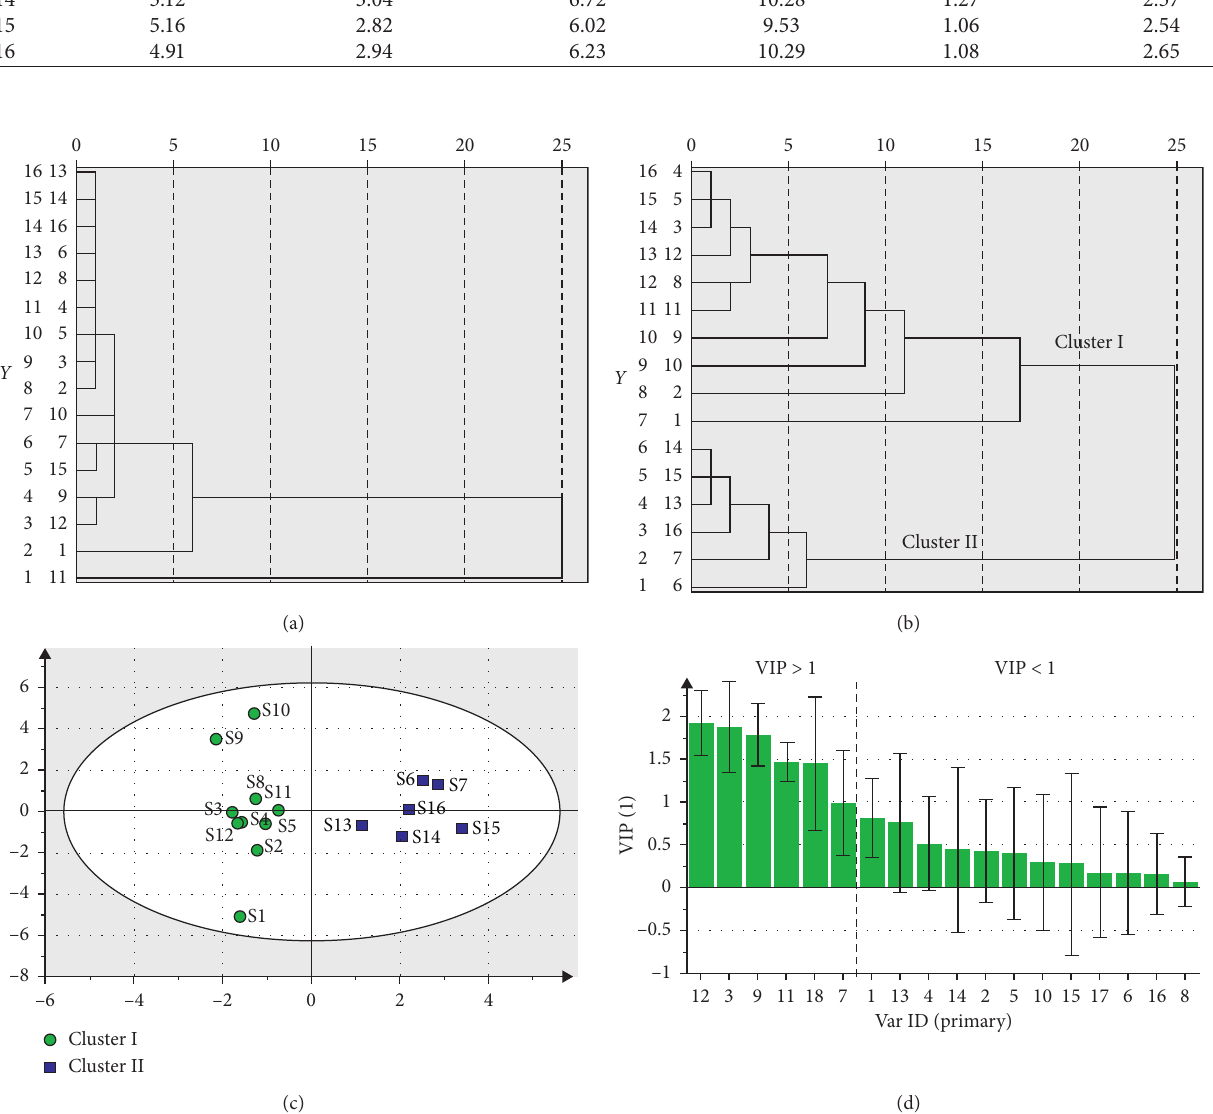
Figure 3: (a) Dendrogram of cluster analysis of 16 batches based on the single-wavelength fingerprint (250 nm). (b) Dendrogram of cluster analysis of 16 batches based on the multiwavelength fingerprint. (c) OPLS-DA score scatter plots of 16 batches of XCQG. (d) Variable important plot